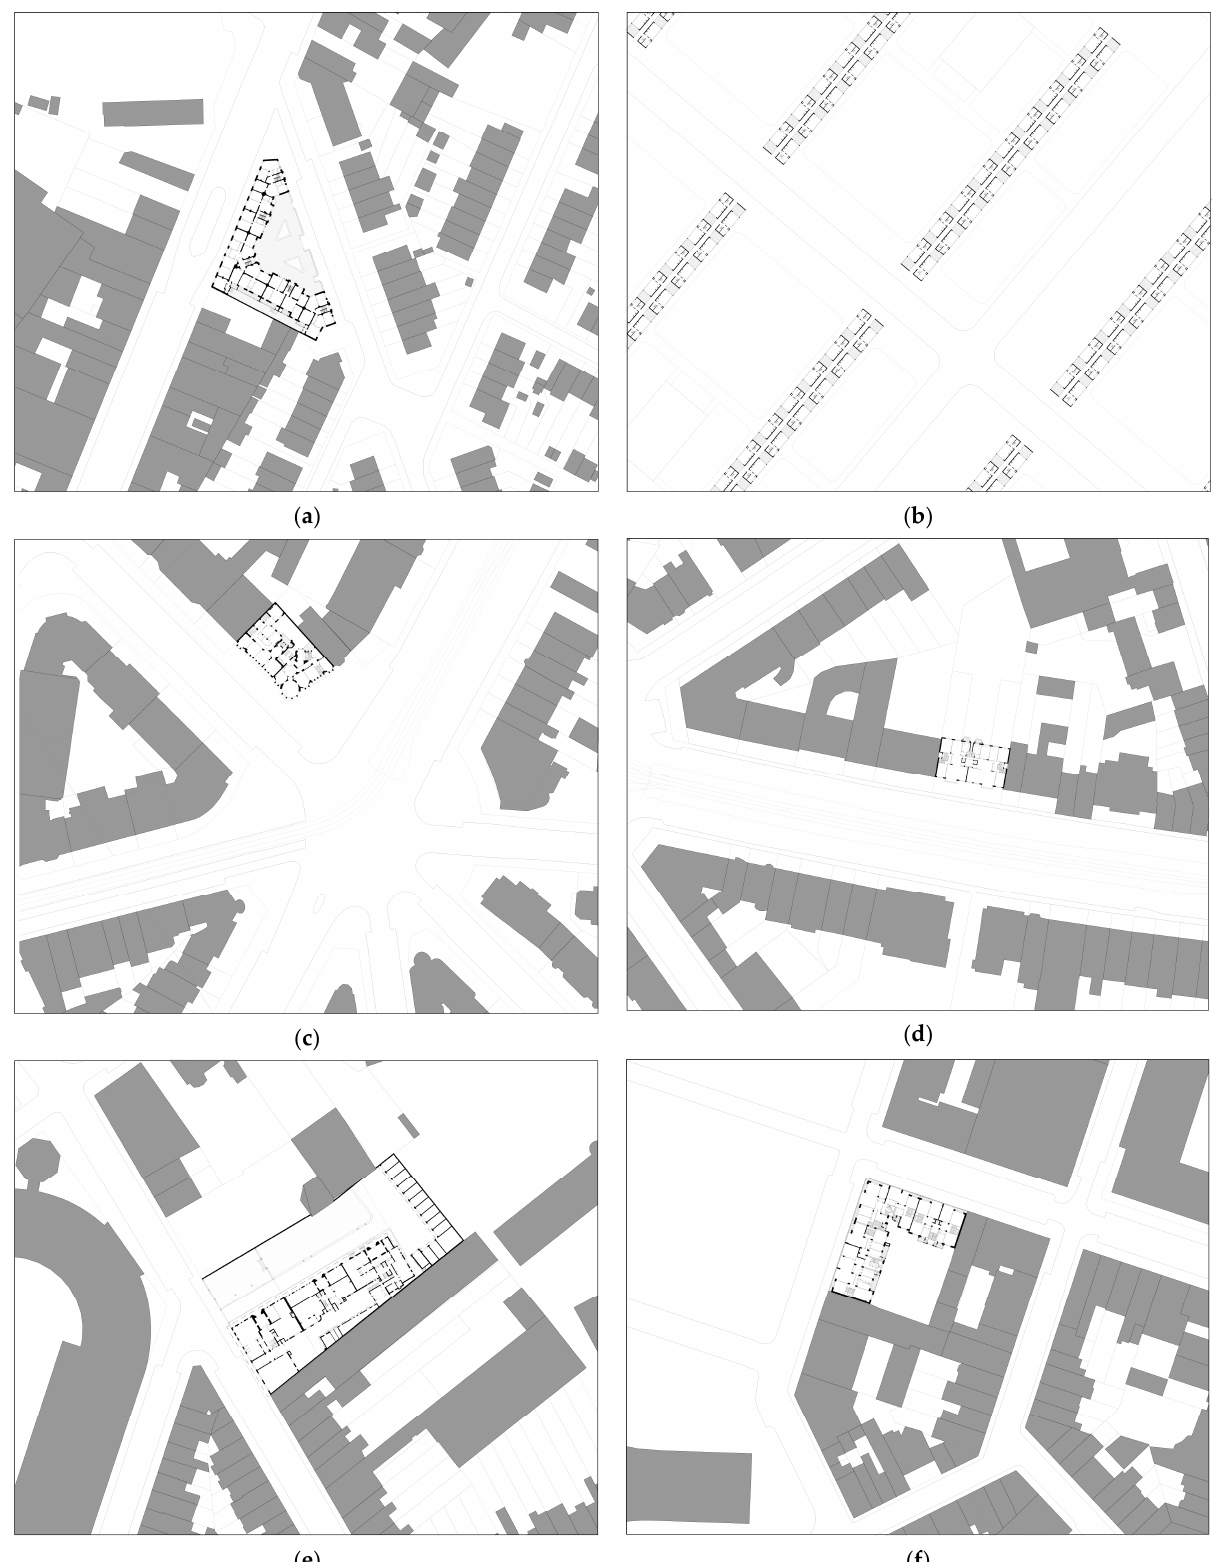
Figure 3. Urban layouts of selected interwar types (re-drawings by the authors): ( a ) Fernand Brunfaut, Cit é Melckmans (1928); ( b ) Victor Bourgeois, Le Nouveau Bruxelles (1930); ( c ) Antoine Courtens, rond-point de l’Etoile 2 (1931); ( d ) Jean- Florian Collin, avenue Churchill 126 (1935); ( e ) Marcel Peeters, Les Pavillons Français (1935); ( f ) Jean-Jules Eggerickx and Raphaël Verwilghen, R é sidence Leopold